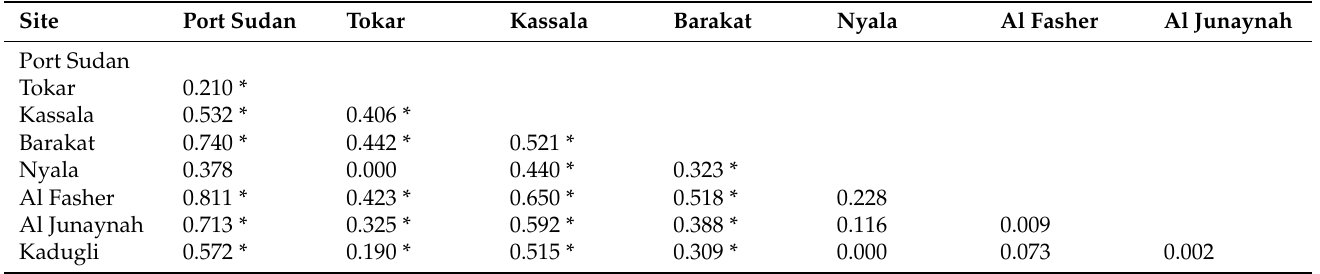
Table 3. Aedes aegypti population divergence between ND4 mitochondrial gene sequences ( F ST value) in the different study sites from